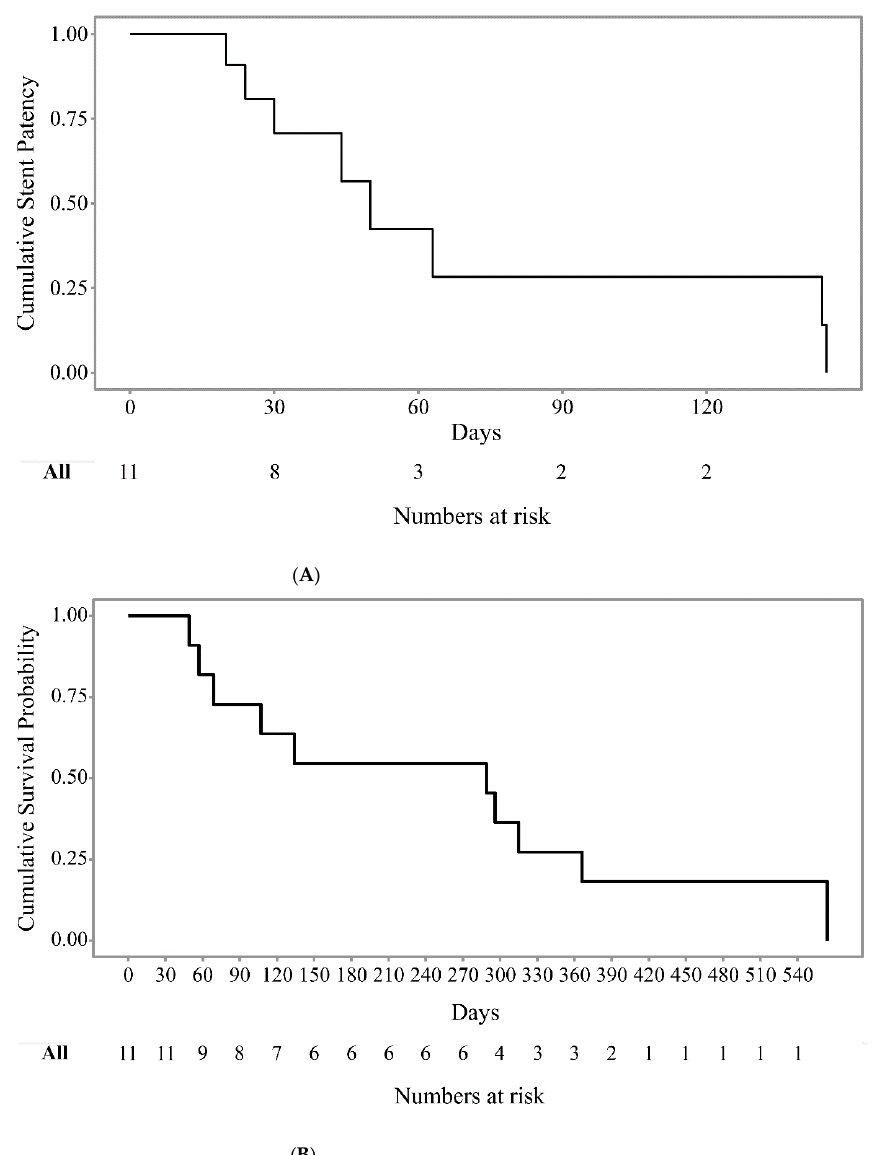
Figure 3. Kaplan–Meier curve showing the cumulative stent patency ( A ) and cumulative patient survival ( B ) after endobiliary radiofrequency ablation. Table 2. Outcomes and adverse events of endobiliary radiofrequency ablation for hilar cholangio- carcinoma.